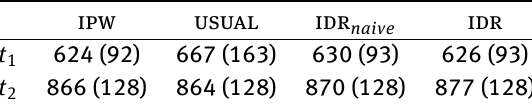
Table 3: Results from the infusion trial. Table entries are multiplied by 10 4